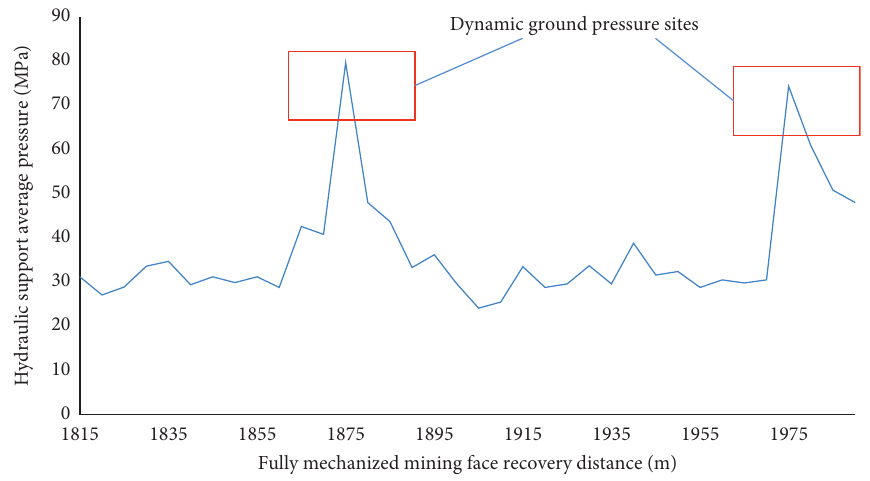
Figure 4: Upslope of the pressure curve of the working